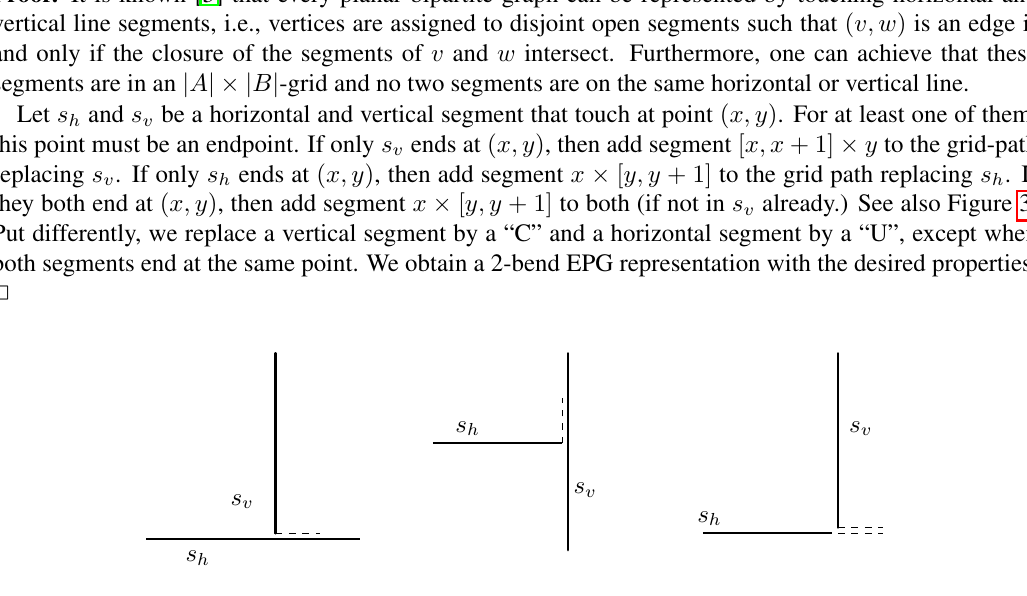
Fig. 3: Converting a representation by touching segments into an EPG representation with at most 2 bends per